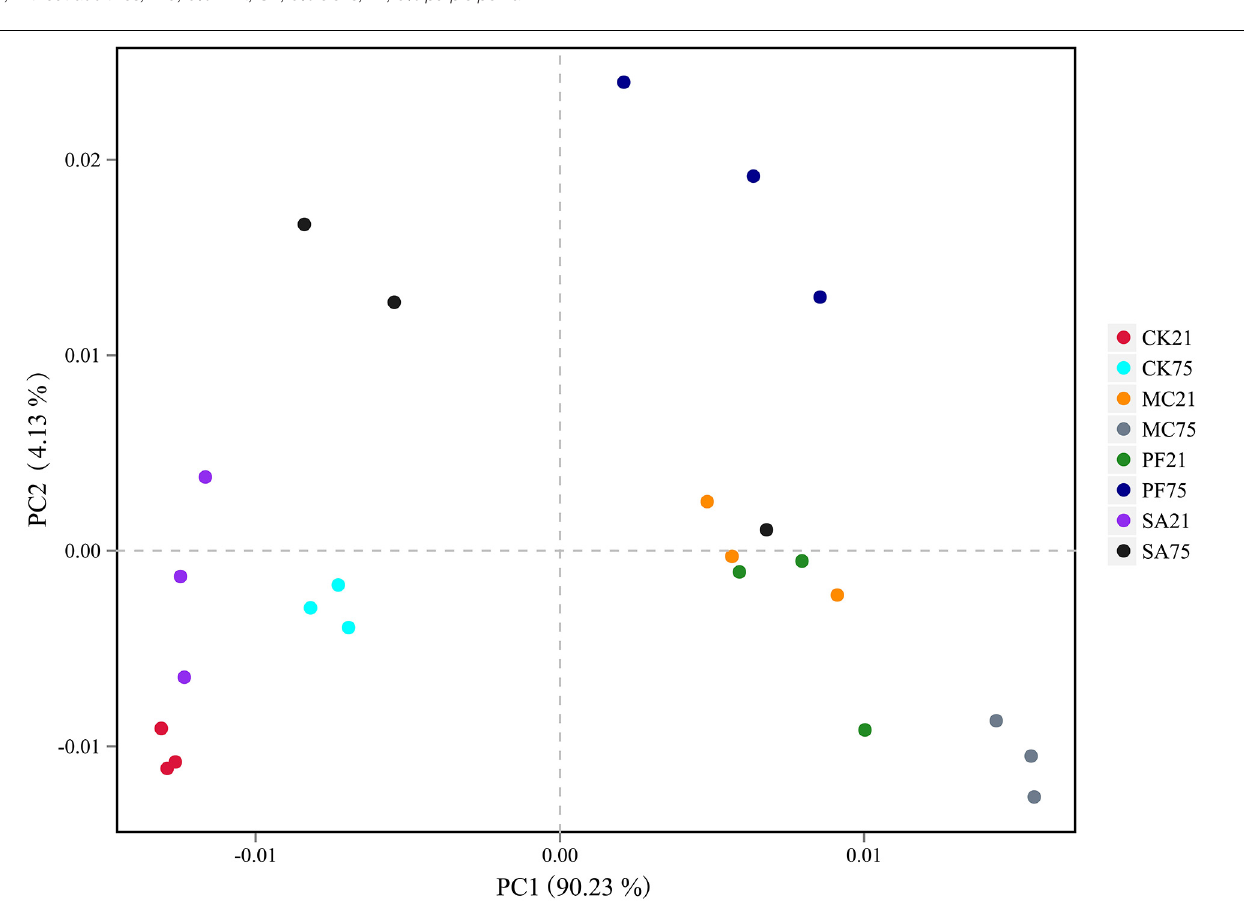
FIGURE 1 | Principal component analysis (principal component) based on OTU level of paper mulberry silage. CK21, without additives after 21 days of ensiling; CK75, without additives after 75 days of ensiling; MC21, 5% mint after 21 days of ensiling; MC75, 5% mint after 75 days of ensiling; SA21, 5% clove after 21 days of ensiling; SA75, 5% clove after 75 days of ensiling; PF21, 5% purple perilla after 21 days of ensiling; PF75, 5% purple perilla after 75 days of ensiling.